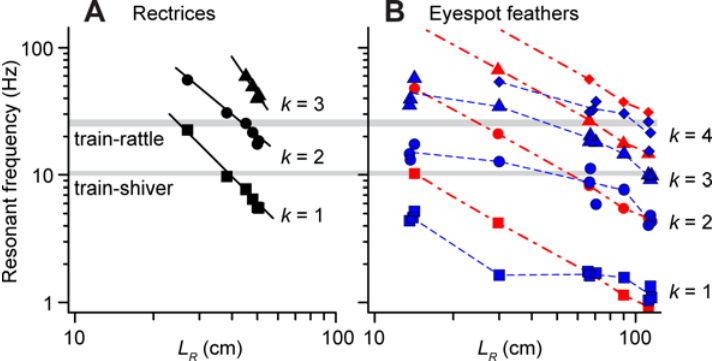
Fig 6. Resonant frequency of single peacock feathers as a function of length. Values of resonant frequency f k for several normal modes of vibration measured in the laboratory for (A) rectrices (black symbols, solid lines) and (B) eyespot feathers (blue symbols, dashed lines). Horizontal gray bands indicate the range of mean frequencies for train-rattling displays (grand mean = 25.6 Hz) and train-shivering behavior (grand mean = 10.4 Hz) performed by adult males (see Table 1 for details). Solid black lines in A show power law scaling relationships for the rectrices calculated from the resonant frequency data. In B the blue dashed lines connect the mean values for each of the five eyespot feather lengths studied. Note that the resonant frequencies of the eyespot feathers in B have a much weaker length-dependence than the rectrices in A. Red symbols and dot-dashed lines in B show the theoretical predictions for the eyespot feathers as described in the text (Eq